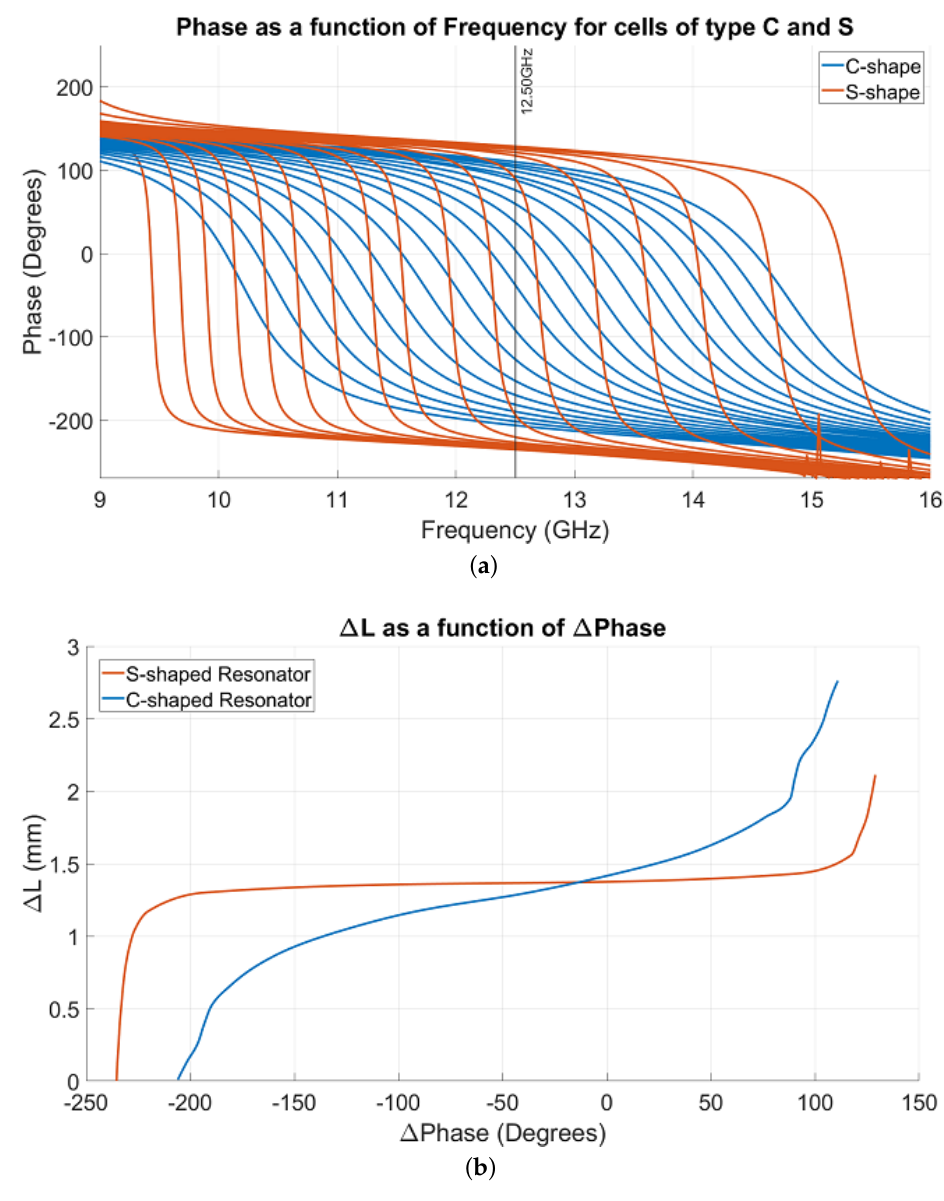
Figure 2. ( a ): Phase versus frequency for cells with C-shaped and S-shaped resonators. ( b ): ∆ L versus ∆ Phase for S-shaped and C-shaped